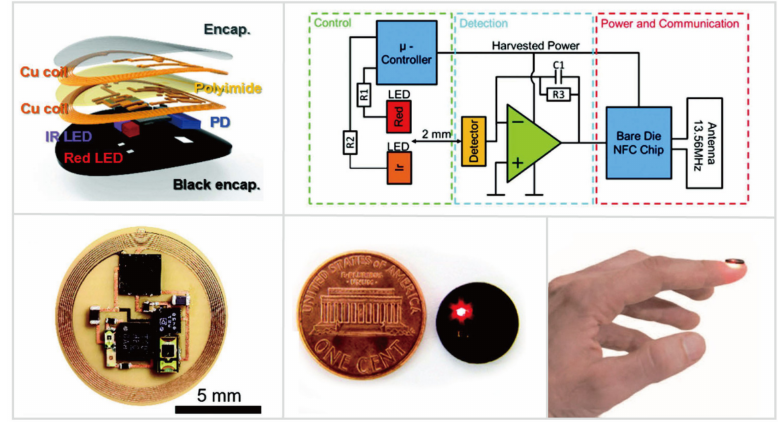
Figure 8. A novel optoelectronic wearable biosensor for wireless, battery-free pulse